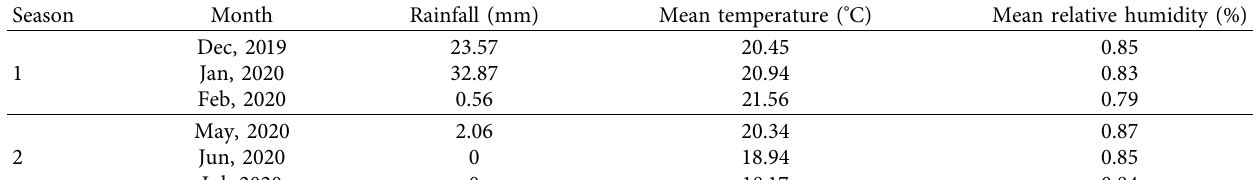
Table 1: Weather data recorded during the growing periods of 2019 and